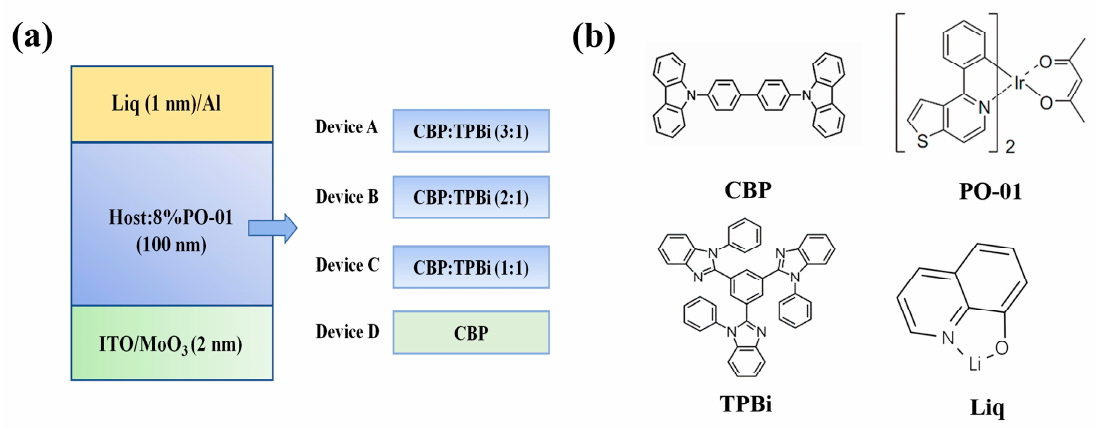
Figure 1. ( a ) The structure of devices A–D; ( b ) the chemical structures of the used